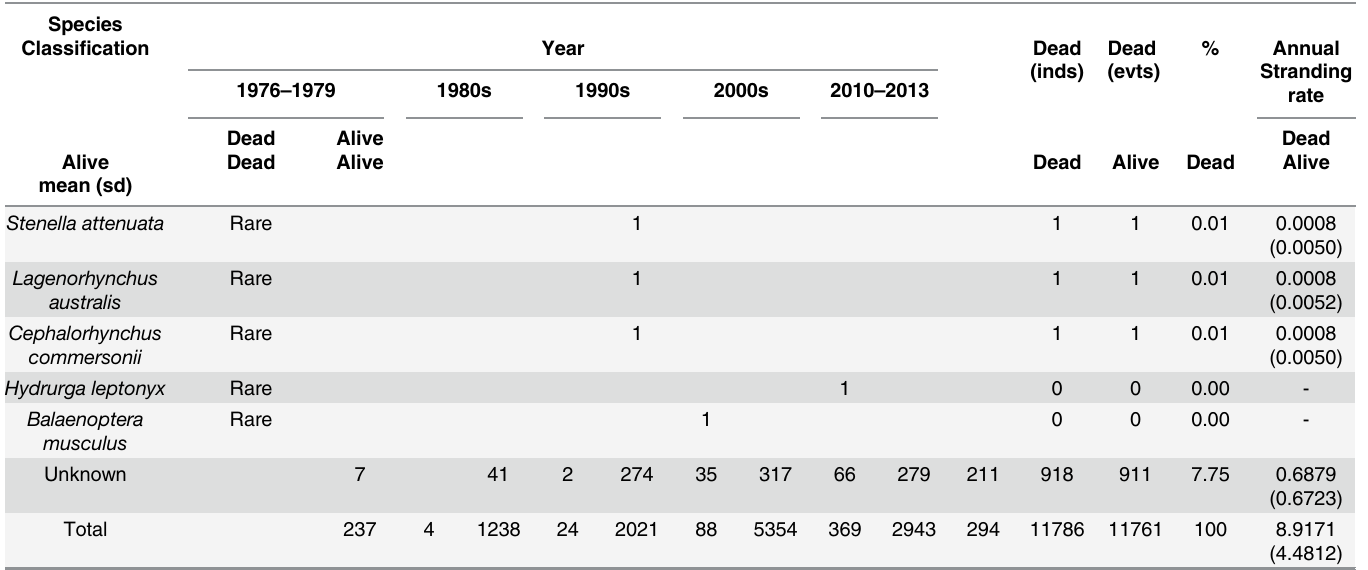
(S1 Table). The decomposition state of stranded animals was determined for 57% (n = 7,186) of the records and of those, 31% (n = 2,276) and 22% (n = 1,628) were putrefied (Codes 4 and 5, respectively).